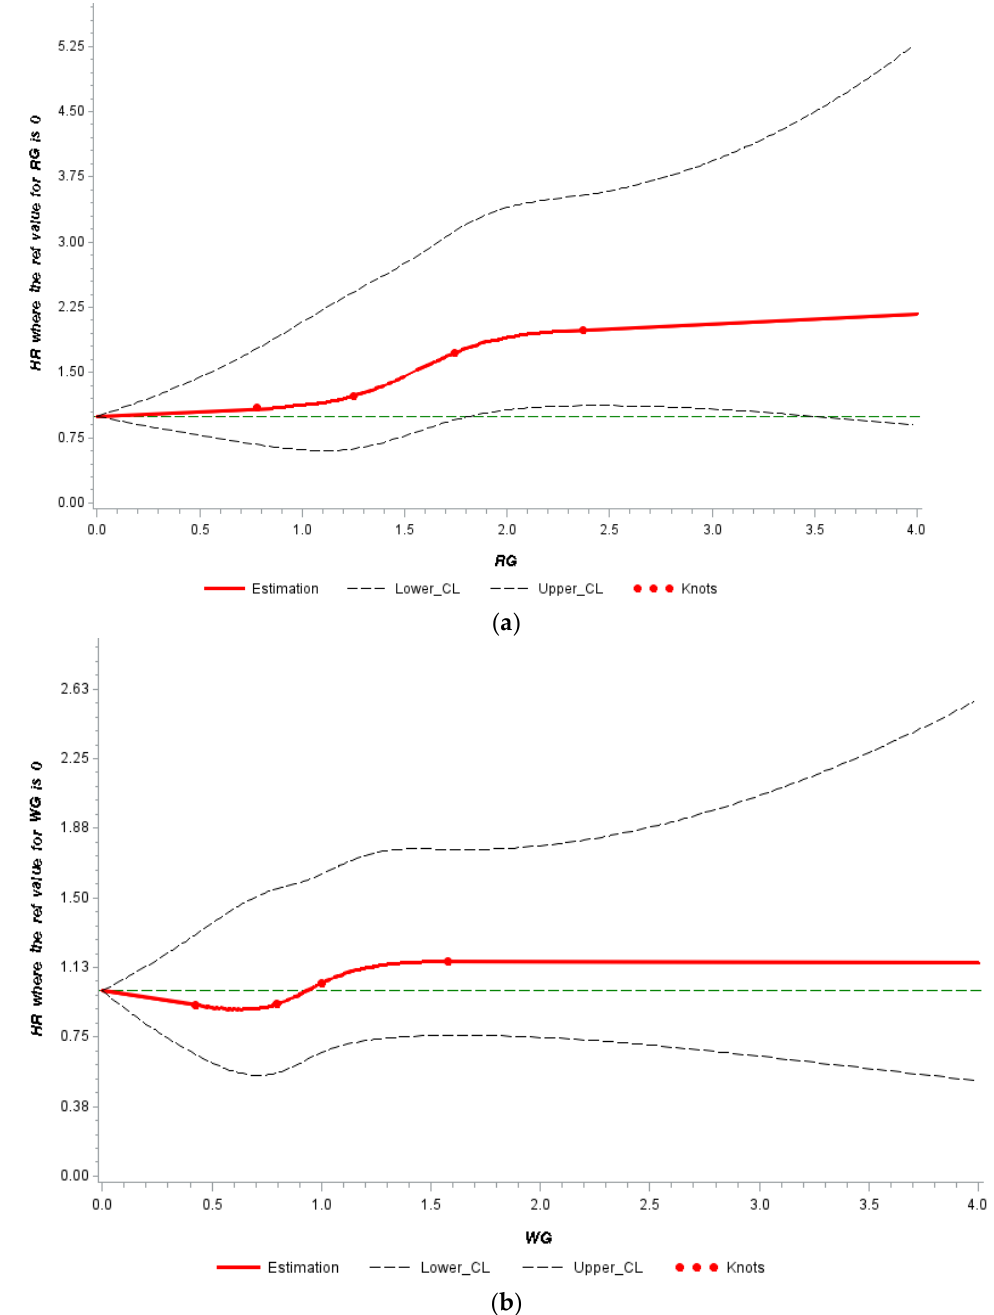
Figure 1. The spline models were adjusted for age at diagnosis, smoking status, cancer stage, chemotherapy, radiation therapy, total calorie and protein intakes, body mass index, menopausal status, hormone status and physical activity. Abbreviations: RG = refined grains, WG = whole grains. ( a ) The association between refined grain consumption and total mortality. ( b ) The association between whole grain consumption and total mortality